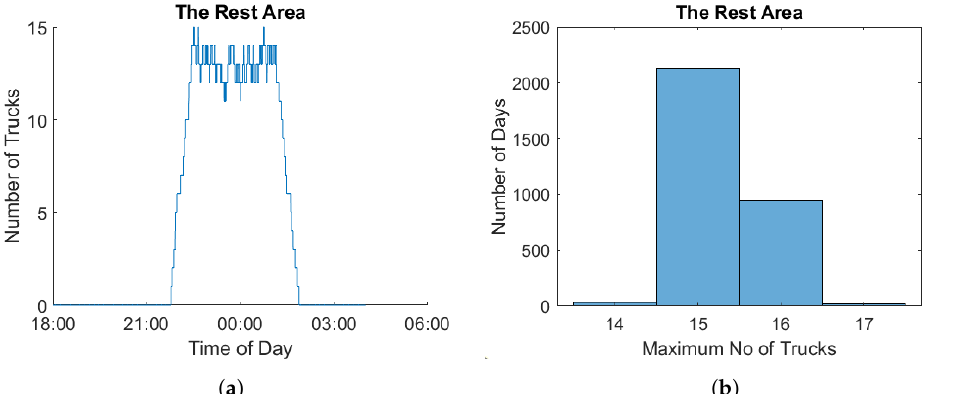
Figure 5. ( a ) The number of charging trucks at the rest area at different times for a day when the trucks are delayed. ( b ) Number of days over a 10-year period when a specific number of chargers is